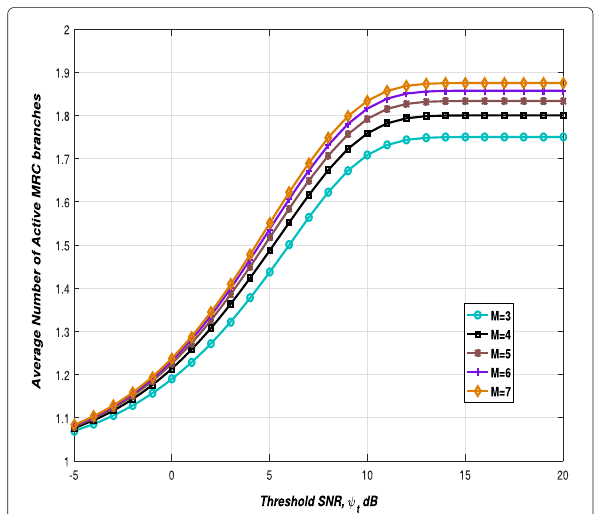
Fig. 3 Exact and asymptotic secrecy outage probability versus ψ 1 for different value of ψ 2 with R s = 1, (cid:3) 2 =10 dB, (cid:3) t =10 dB, σ = 1, and M = 7. Dotted lines represent the asymptotic results